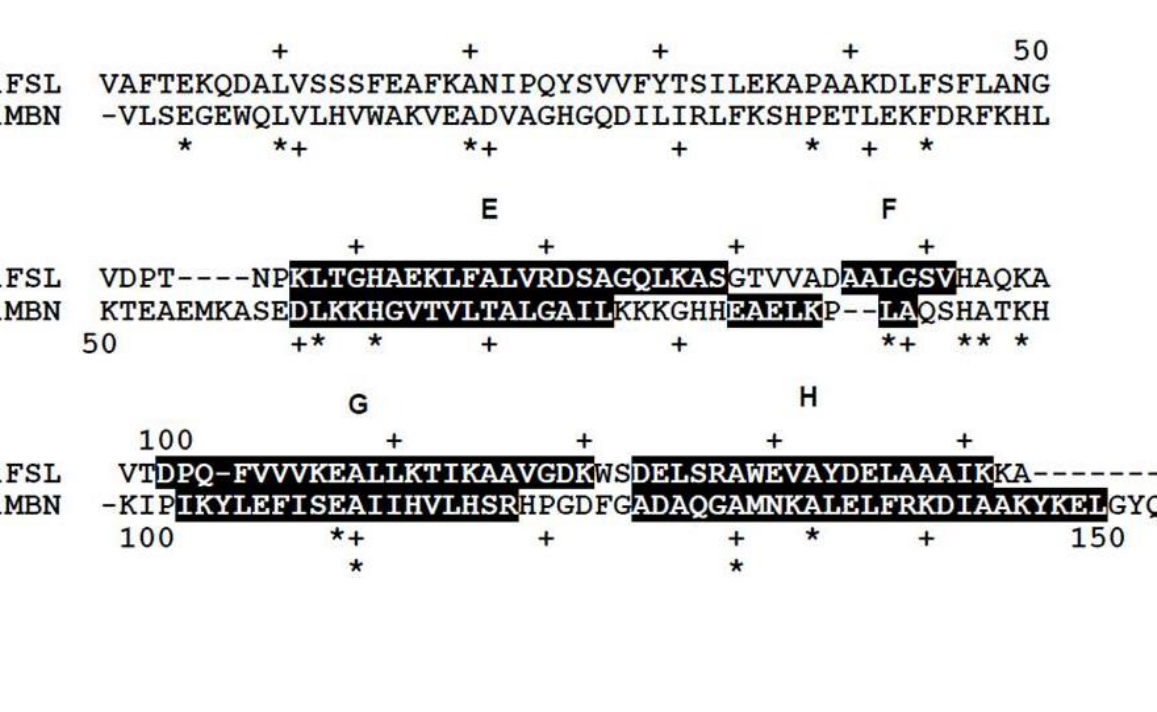
Figure 1. Amino acid sequence alignment of soybean leghemoglobin (PDB: 1FSL) and sperm whale myoglobin (PDB: 1MBN). The amino acid sequence identity is 15%. White letters with a black background denotes a residue in the  -helices of the E-to-H helix unit. The portions labeled by E, F, G and H refer to these  -helical